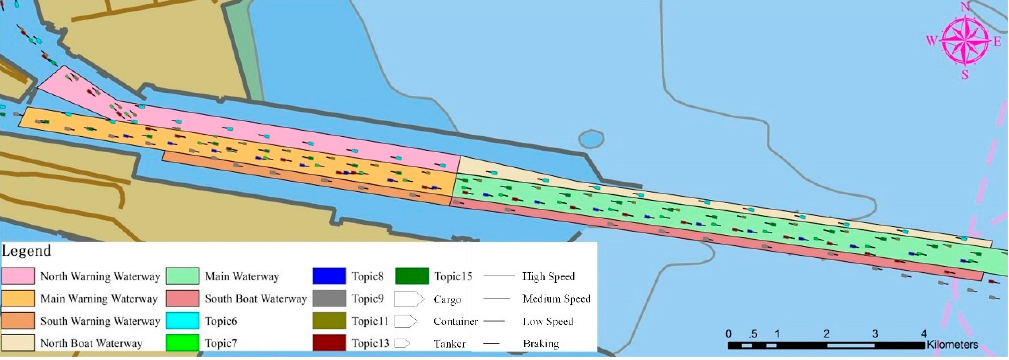
Figure 13. Visualization of the spatial distribution of seven representation motion pattern topics entering and leaving the Tianjin port waterway.